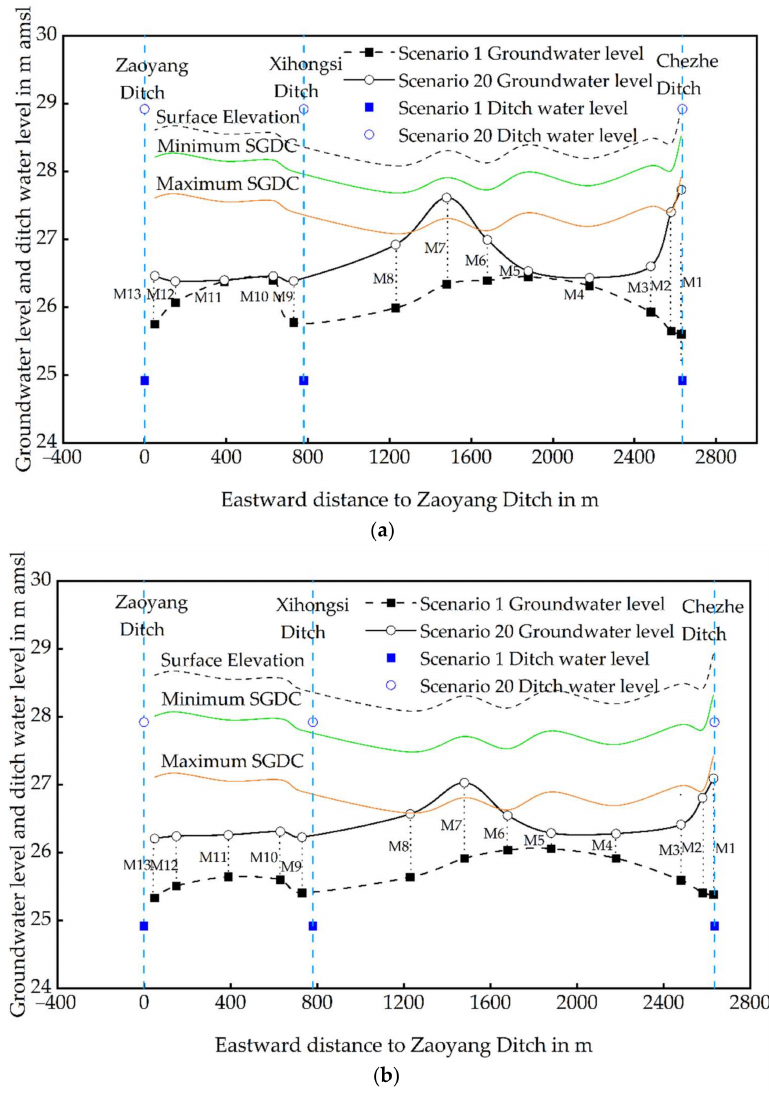
Figure 5. Cross-section of groundwater level in middle line for corn and wheat of Scenarios 1 and 20: ( a ) 17 August 2008, during corn reproductive stage; ( b ) 12 April 2008, during wheat reproduc- tive